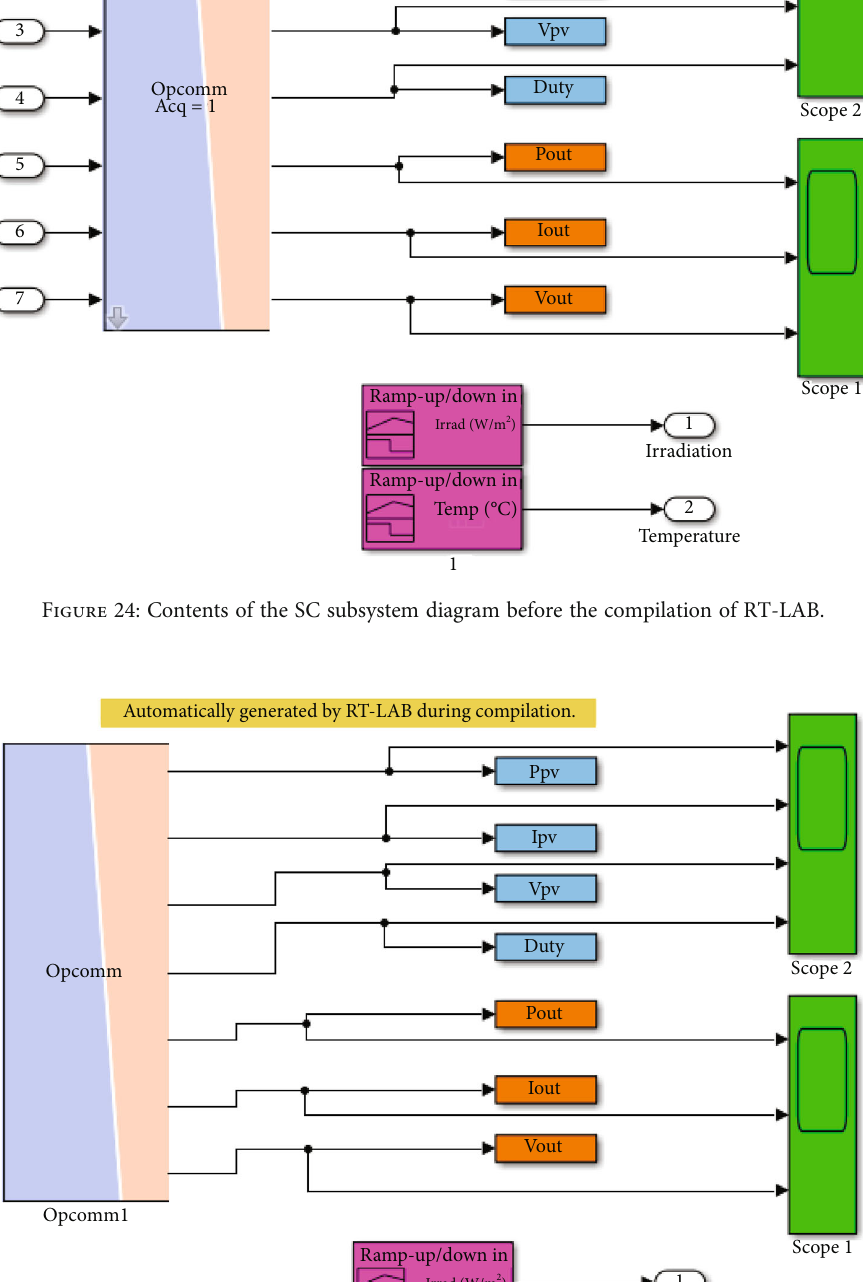
Figure 25: Contents of the SC subsystem diagram after the compilation of